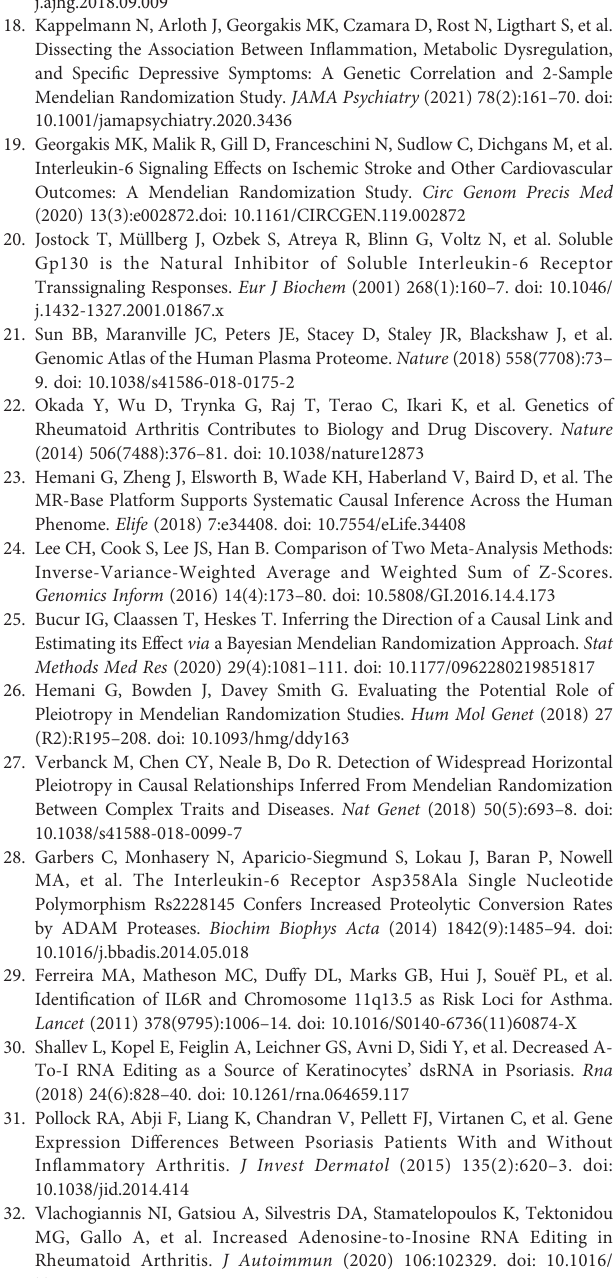
Supplementary Figure S1 | Forest plots and “ leave-one-out ” plot for MR analyses of the causal effect of IL6 on autoimmune arthritis in pooled population. Supplementary Figure S2 | Forest plots and “ leave-one-out ” plot for MR analyses of the causal effect of IL6 on autoimmune arthritis in female or male population. Supplementary Figure S3 | Violin plot and multiple tissues expression level of